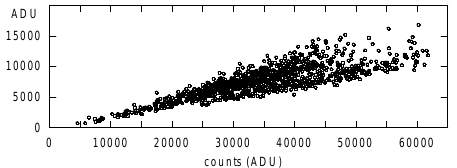
Fig. 2. Maximum count rates for η Car (X-axis) and HD 303308 (Y-axis). Source: Sterken et al. (2001).